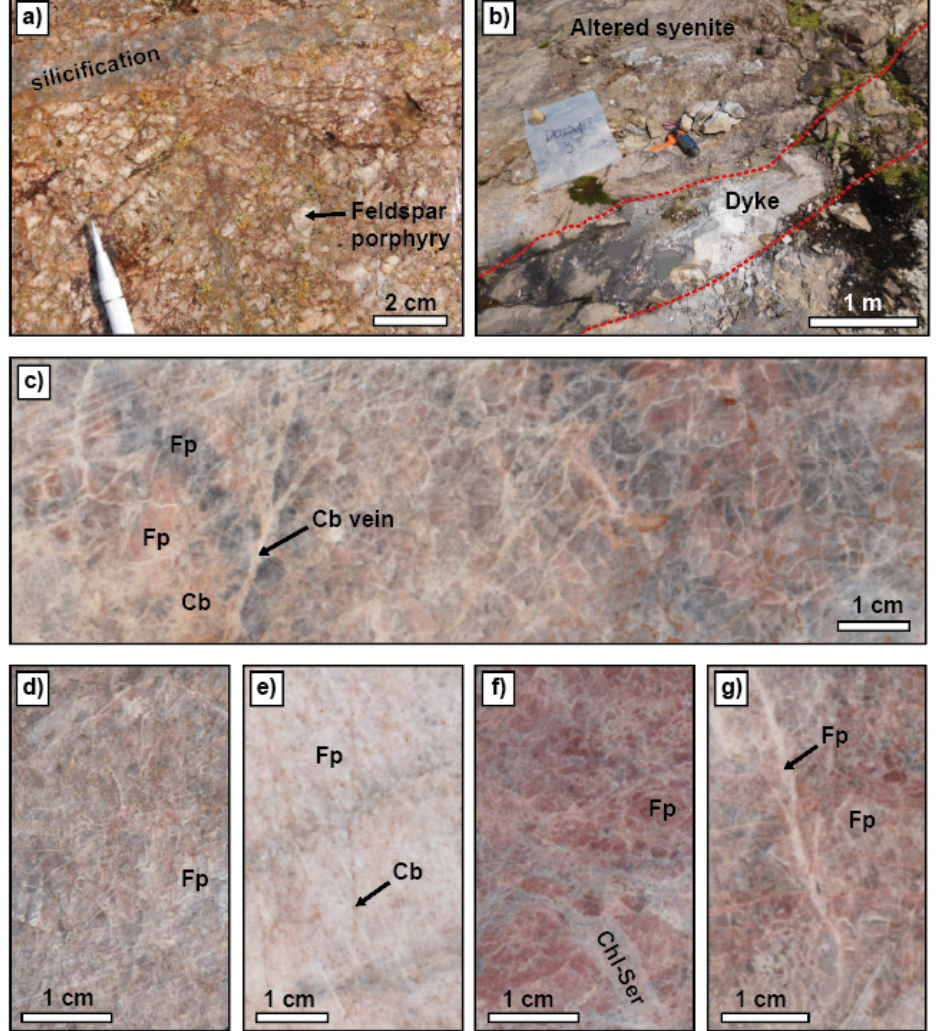
Figure 2. Outcrop photographs showing a feldspar-phyric intrusive phase that is hematized and locally silicified ( a ), and showing the 1 m thick aplite dyke from which sample D3 was obtained ( b ). Scanned rock sections showing samples D1A ( c ), D2 ( d ), D3 ( e ), D4 ( f ), and D5 ( g ). The abbreviations stand for carbonate (Cb), feldspar (Fp), chlorite (Chl), and white mica produced by the sericitization process (Ser).